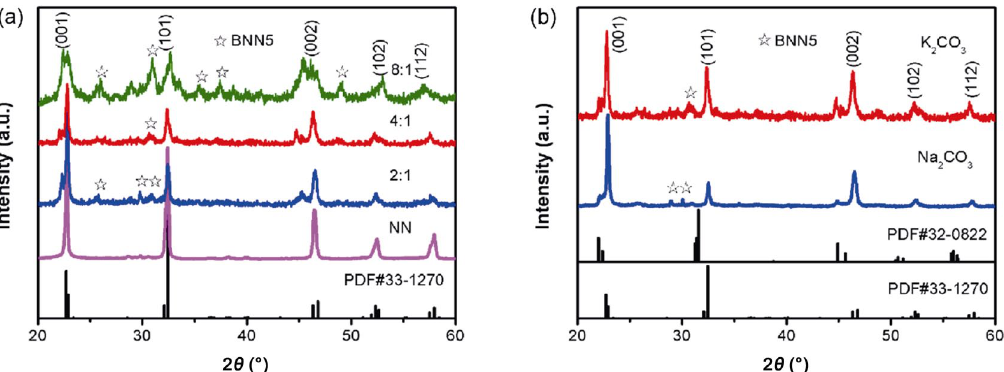
Fig. 3 XRD patterns of KNN platelets synthesized with (a) different ratios of KCl/NaCl and (b)